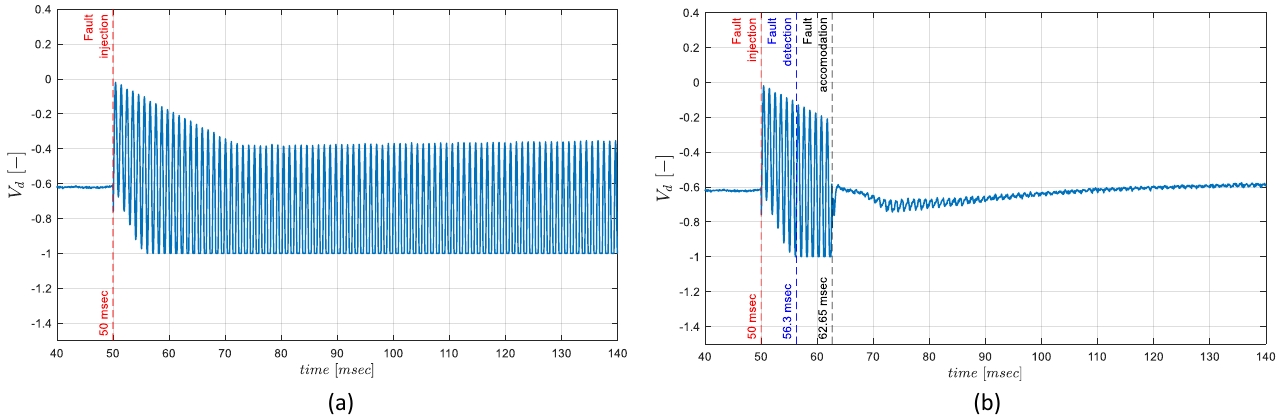
Figure 13. Normalized direct voltage with open circuit on phase a at t = 50 msec ( V lim = 270 V): ( a ) without FTC, ( b ) with FTC.